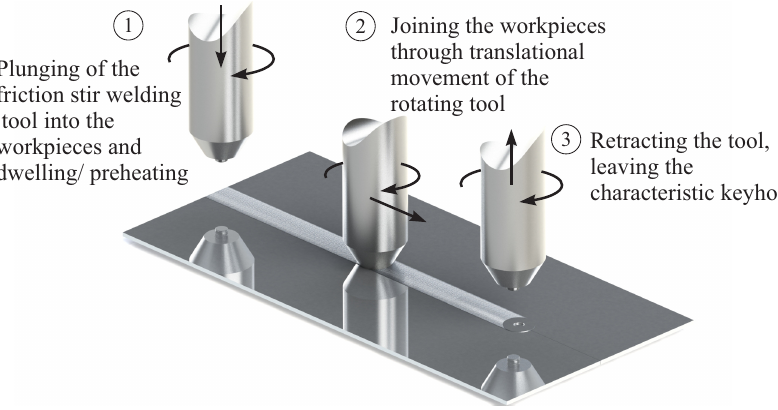
Figure 1. The three process steps of friction stir